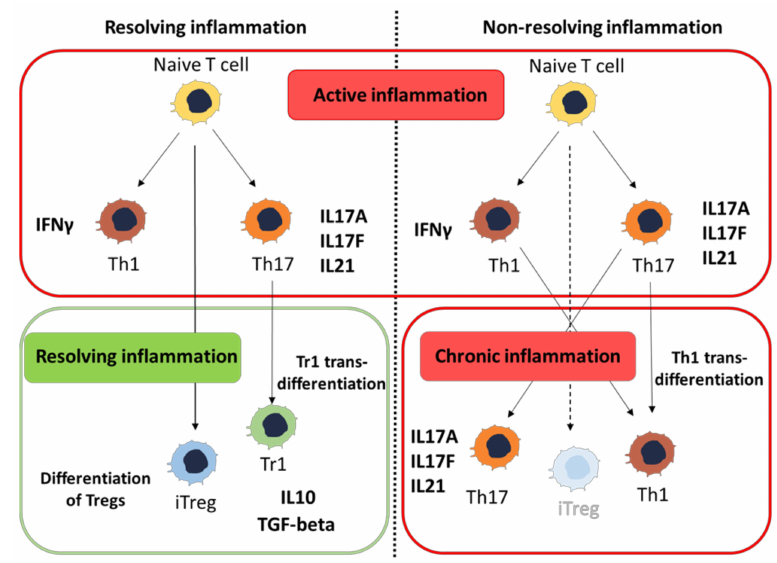
Figure 2. The role of peripheral induction of regulatory T cells (Tregs) and trans-di ff erentiation of T helper 17 (Th17) cells in Tr1 or Th1 cells in inflammation